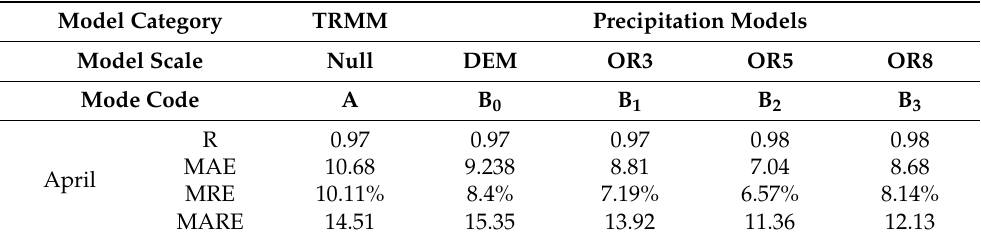
Table 2. Statistical results of the precipitation model in Central China verified by encryption